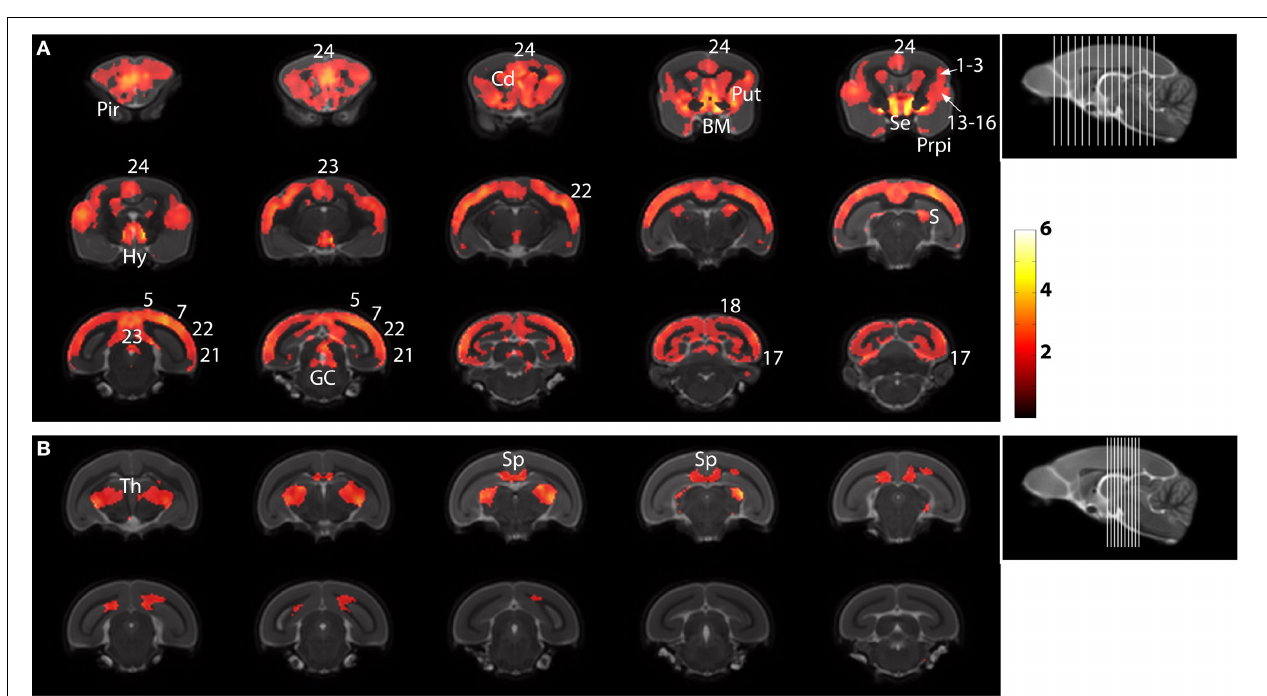
Finally a good correlation was detected between the total CSF volume and the atrophy of the cingulated regions (23 and 24), the temporal regions (22 and 28), the frontal areas 4 and 6, and